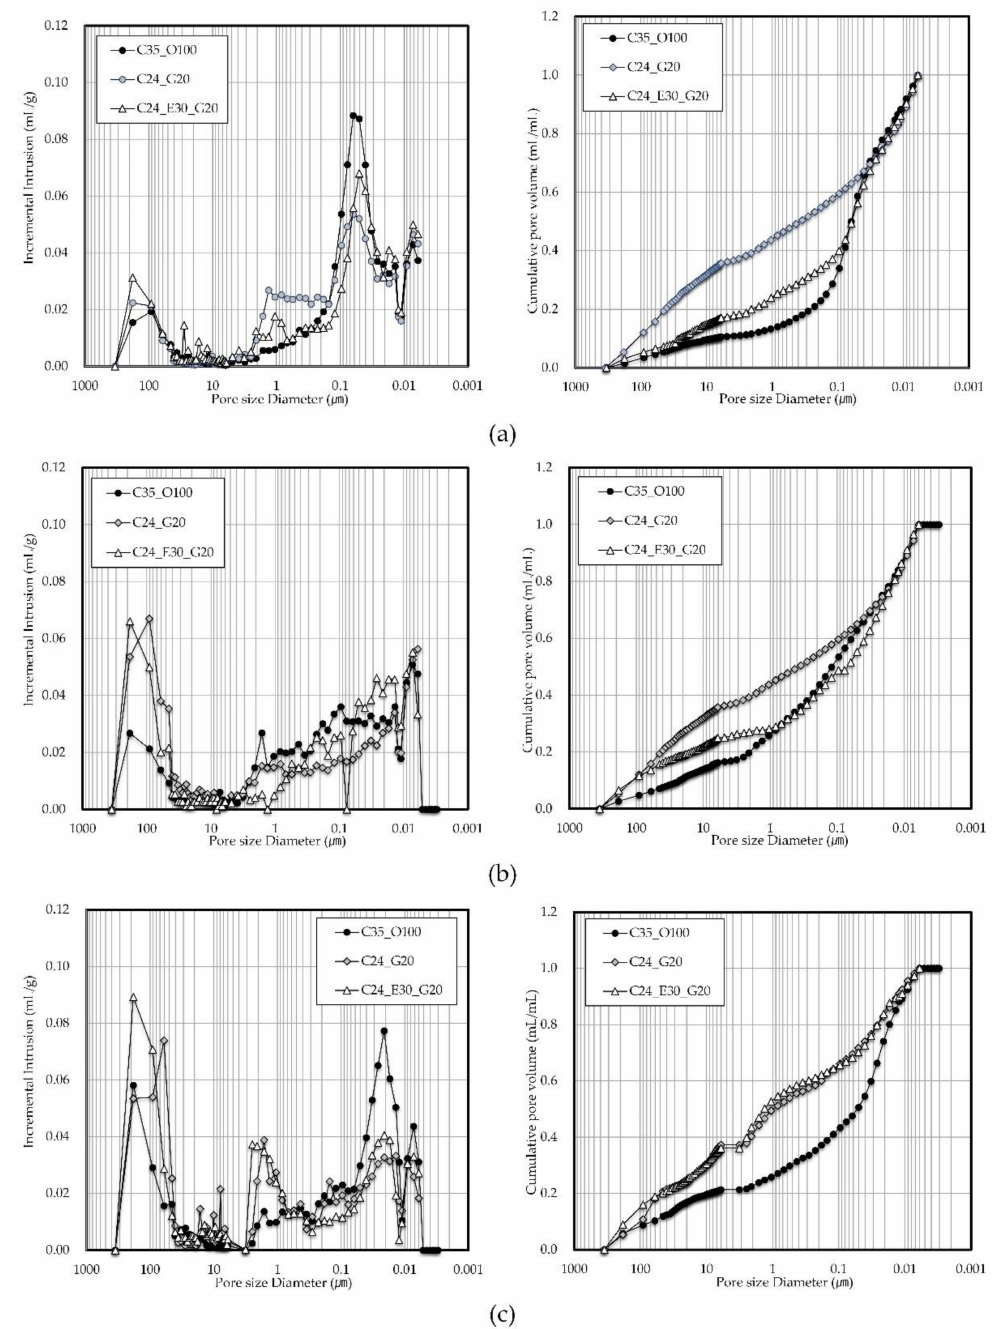
Figure 11. Results of pore structure by mercury intrusion porosimetry: ( a ) 7 days; ( b ) 28 days; ( c ) 91